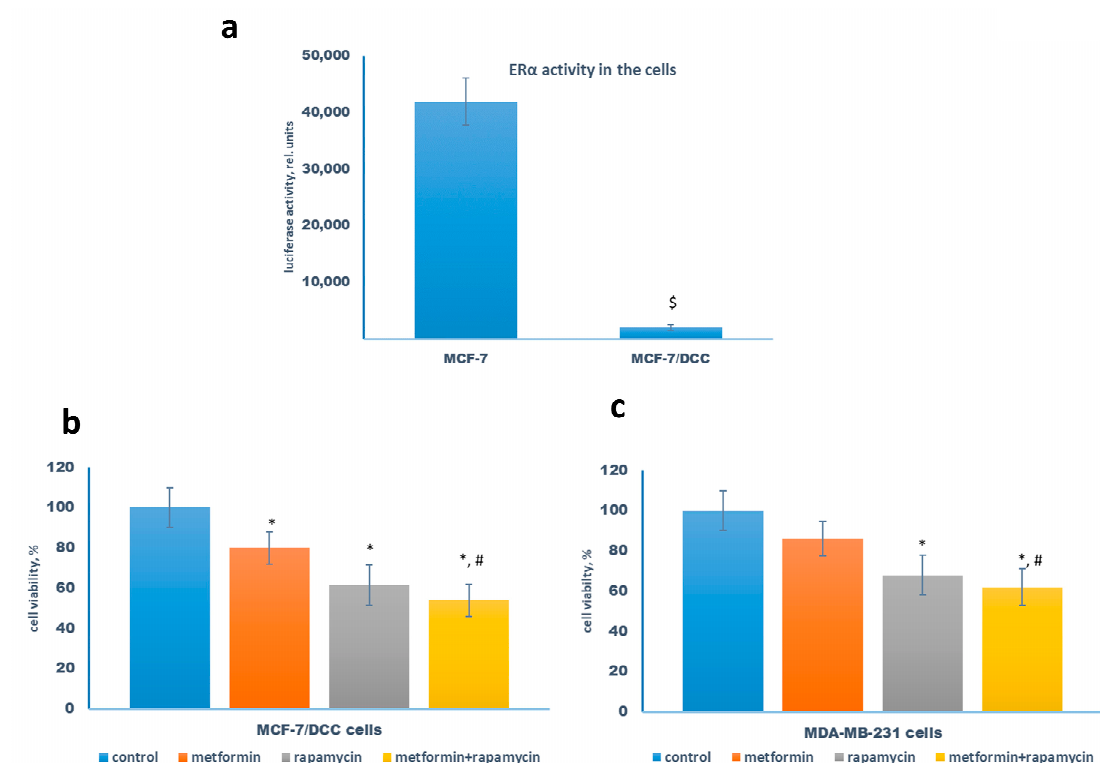
Figure 6. ER α inactivation and cell sensitivity to rapamycin. ( a ) The comparative analysis of the transcriptional activity of the estrogen receptor in MCF-7 cells and MCF-7/DCC cells, pretreated in the steroid-depleted medium for 3 days. The ERE luciferase and β -galactosidase activities were determined as described in Materials and Methods. Data represent the mean value ± SD of three independent experiments. ( b , c ) The sensitivity of MCF-7/DCC cells and ER α -negative MDA-MB-231 cells to metformin and rapamycin. The cells were treated without or with 1 µ M rapamycin in the presence or absence of 2 mM metformin for 3 days, and the amount of the viable cells was counted by the MTT-test. Data represent the mean value ± SD of three independent experiments. p < 0.05: $ versus MCF-7 cells, * versus control, # versus metformin-treated cells.